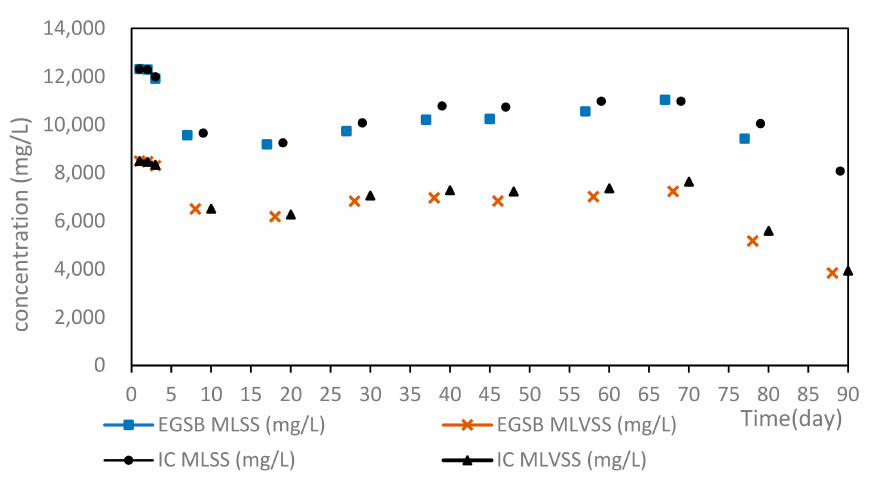
Figure 16. Changes in sludge concentration in the two